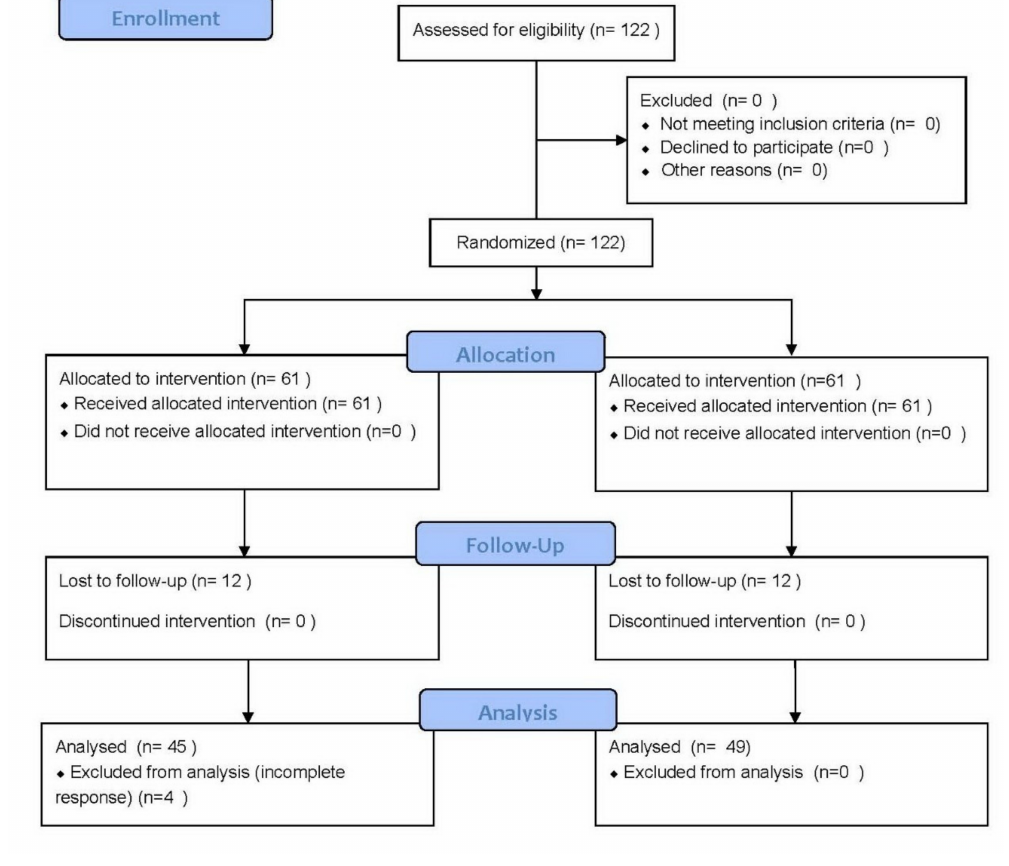
Figure 1. Trial flow